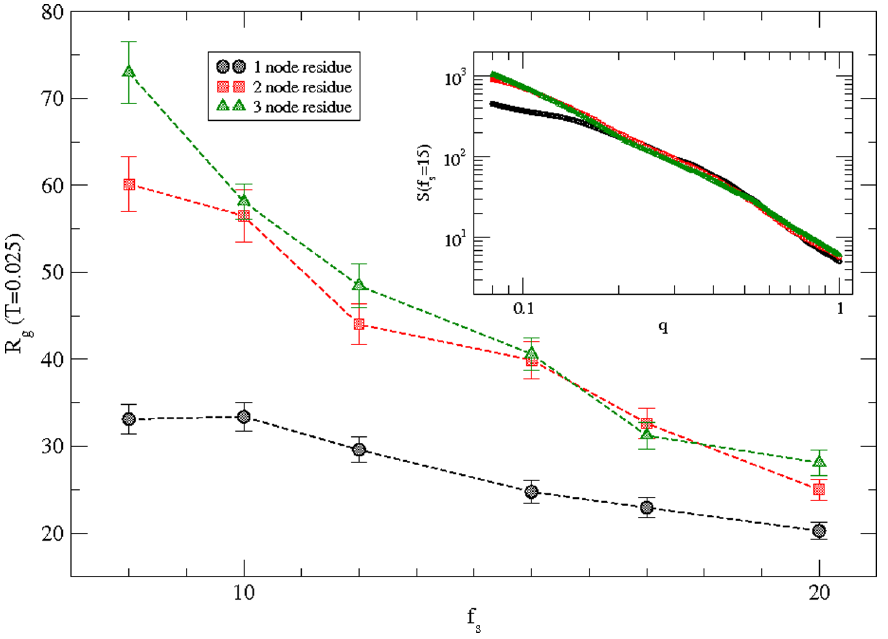
Figure 7. Variation of the radius of gyration of the protein with the magnitude of the solvent interaction at a temperature T=0.025 for protein h3.1 with multi-grain representations, i.e., one node, two nodes, and three nodes to represent each residue. Simulations are performed on a 64 3 lattice with one node residue and on 100 3 and 210 3 lattices with two-node and three-node residues representations respectively. 100 independent samples with one-node, 50 with two-node, and 25 with three-node representations are used at each solvent strength. The inset is the structure factor S(q) versus wave vector q on a log-log scale at a representative solvent interaction strength f s =15 .